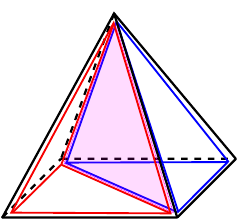
Figure 6 . Illustrative example for fusing faces in triangulated cones. We draw the intersection a non-simplicial cone (the pyramid) of a 4-dimensional fan with the unit sphere S 3 . This cone is triangulated by two simplicial cones, drawn in red and blue. These two cones share a codimension-1 face along which we fuse. When doing so, the codimension-2 face on the base of pyramid is also fused and thus